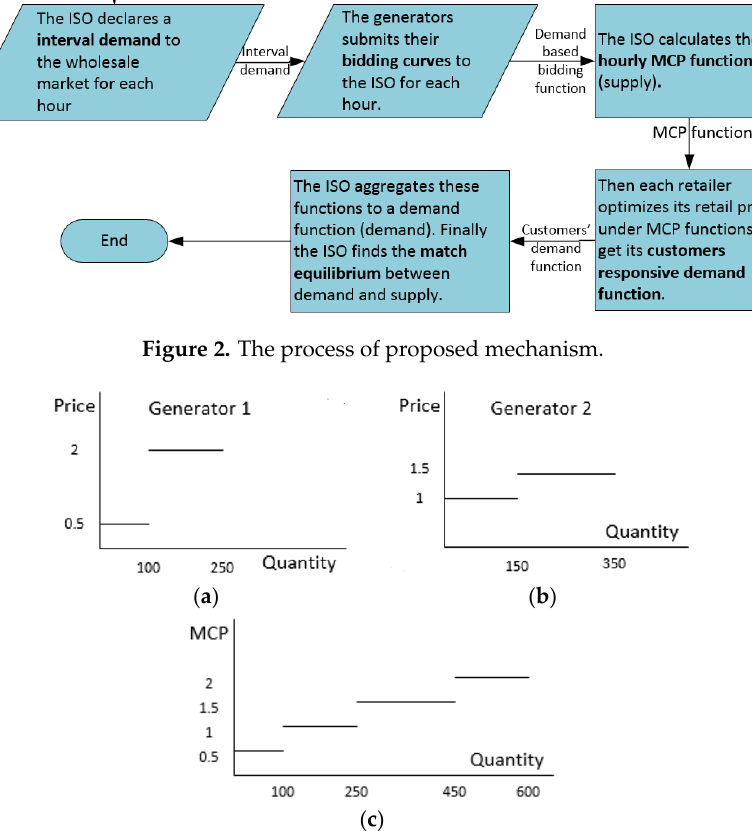
Figure 3. Example of generators’ bid curve and the aggregated bidding curve. ( a ) Generator 1’s bid curve; ( b ) Generator 2’s bid curve ; ( c ) The aggregated bidding curve.